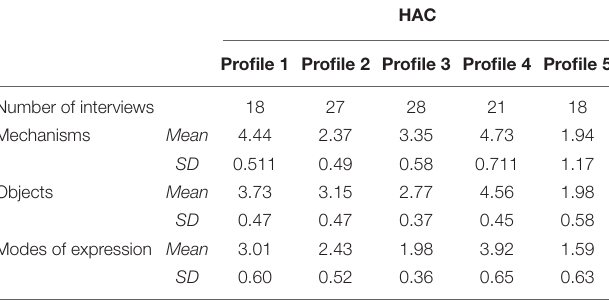
TABLE 2 | Summary of the clusters derived from the hierarchical ascendant